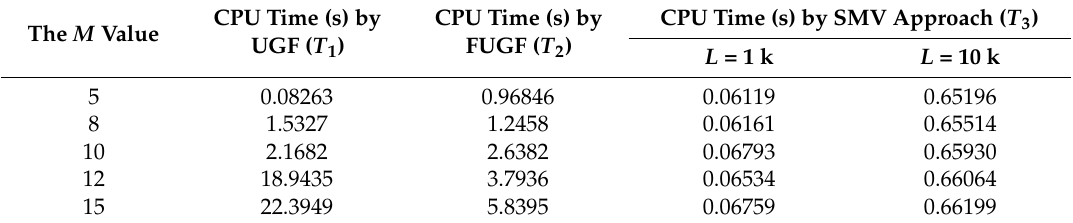
Table 5. Efficiency comparison for a system of model II with 12